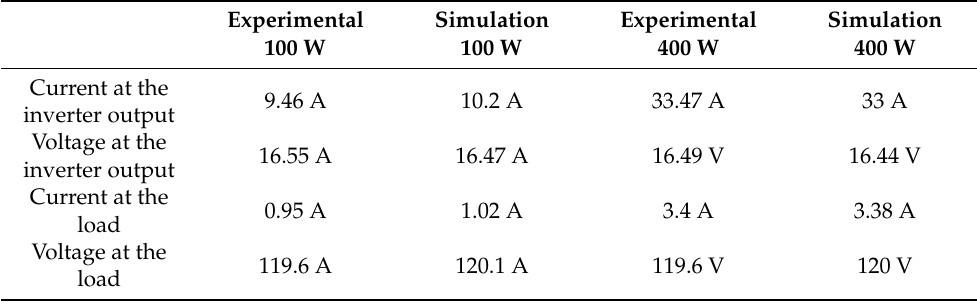
Figure 4. Waveforms for DM. ( a ) Experimental 100 W load. ( b ) Experimental 400 W load. ( c ) Simula- tion 100 W load. ( d ) Simulation 400 W load. Table 1. Experimental and simulation RMS voltage and current values, with loads of 100 W and 400